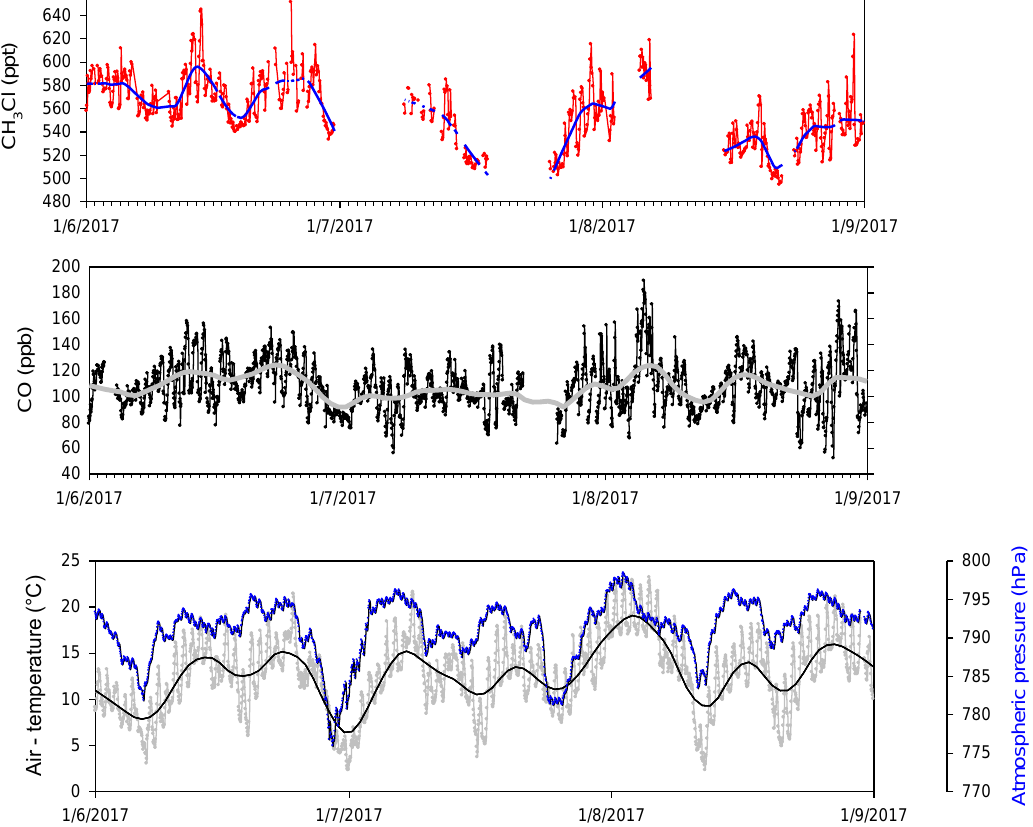
Figure 2. Time series of CH 3 Cl, CO, air-temperature and pressure observed at CMN during summer 2017. The tick lines represent the Loess smoothing .